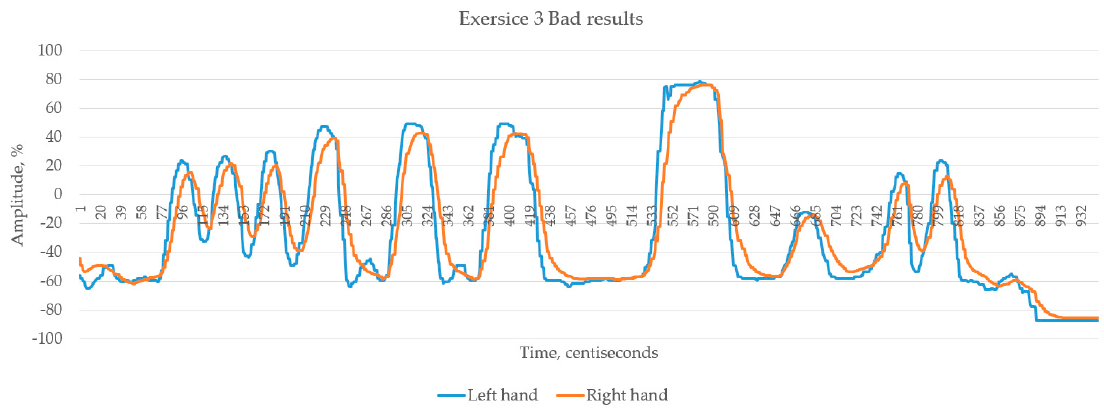
Figure 8. The result of incorrect performance of Exercise 3.